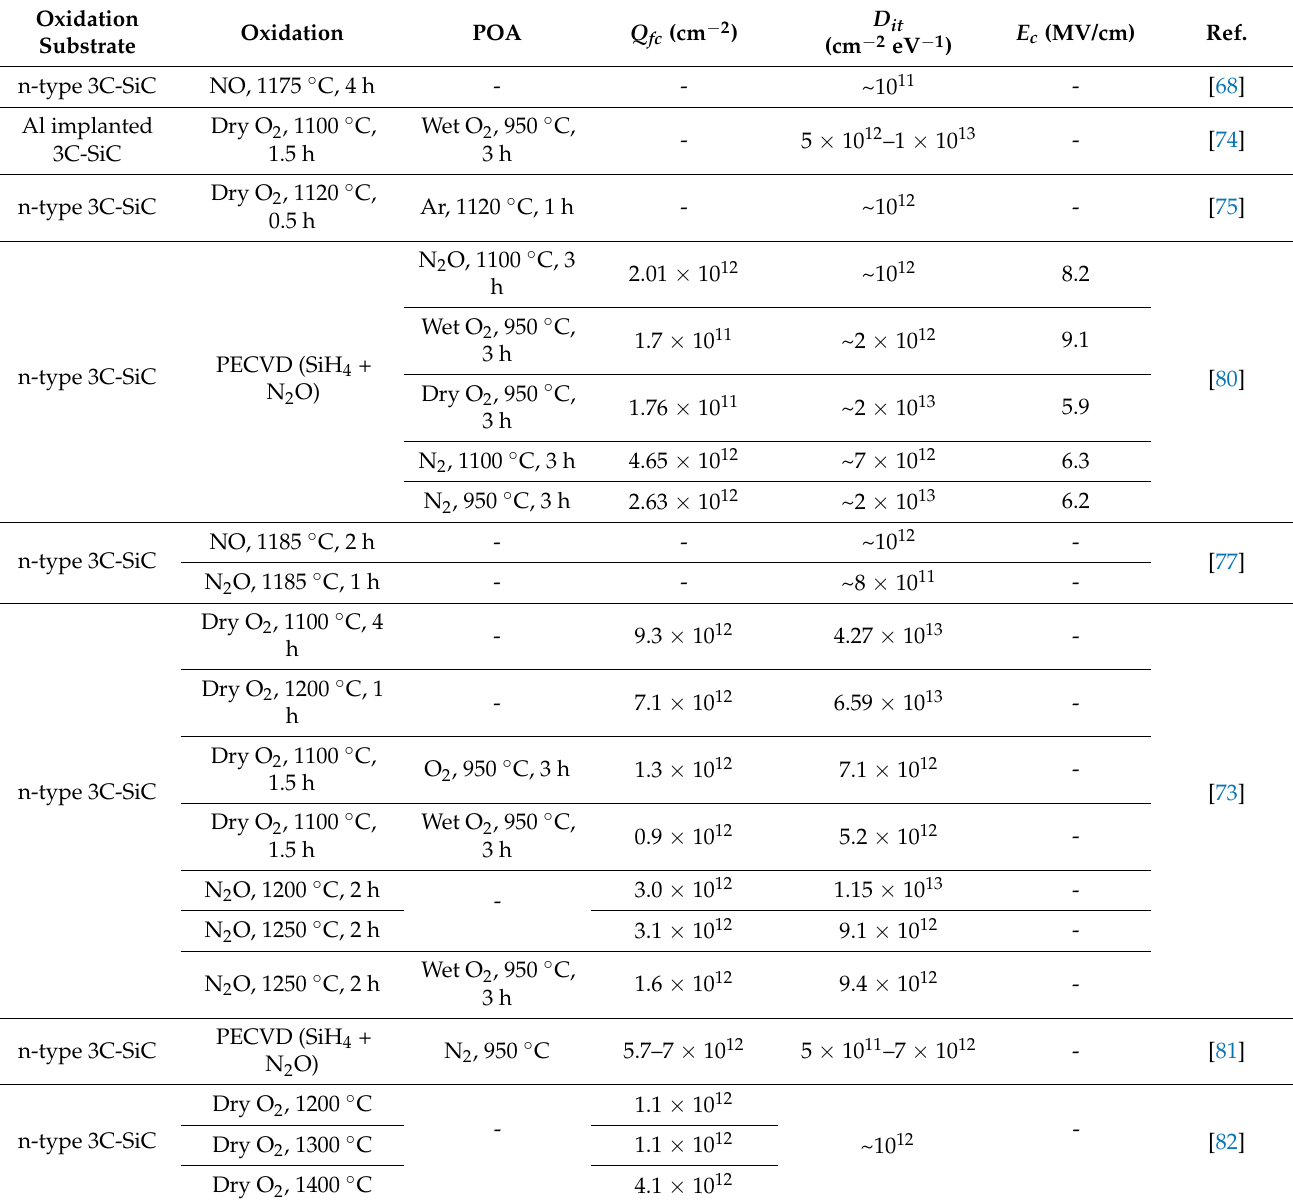
Table 5 is a list of recent work performed on the study of 3C-SiC MOS interface traps. Table 5. A summary of literature data on the processing of 3C-SiC MOS interface and relevant information on fixed charges ( Q fc ), interface trap density ( D it ), and oxide critical field ( E c ), unless specified, the 3C-SiC materials listed are